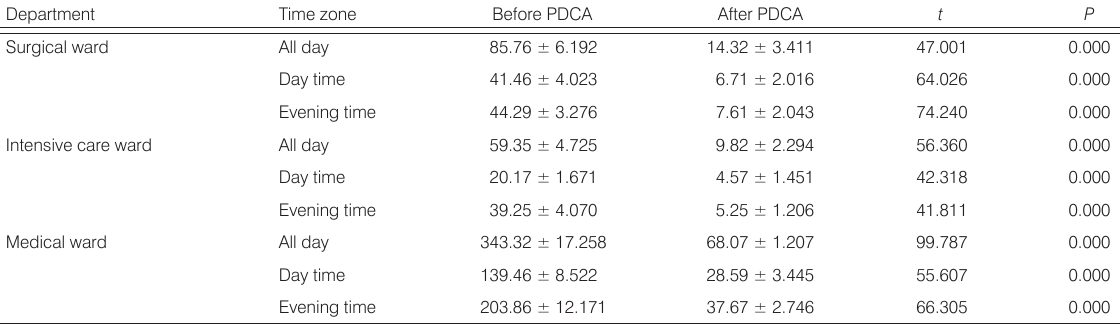
Table 2. The average number of naked medicine before and after the PDCA cycle (M ±